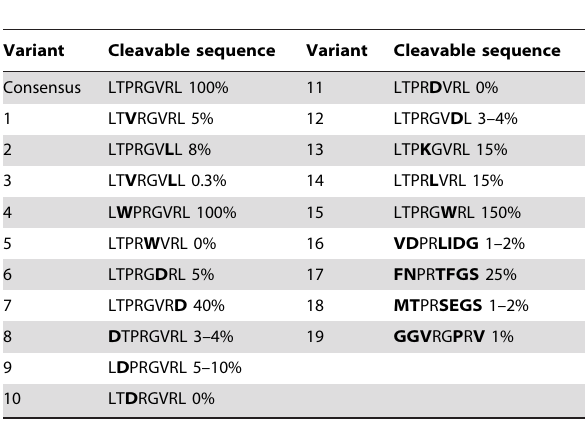
Table 2. Amino acid summary of thrombin cleavage